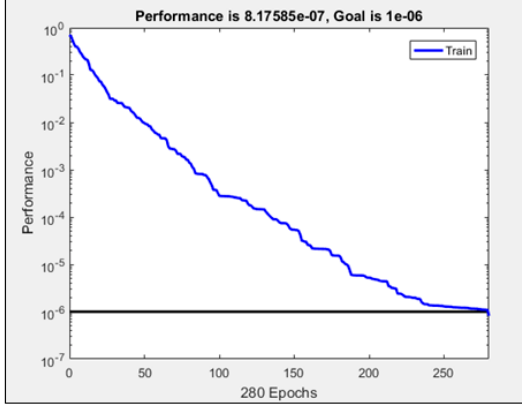
Figure 3. Performance plot of training RBF-ANN.